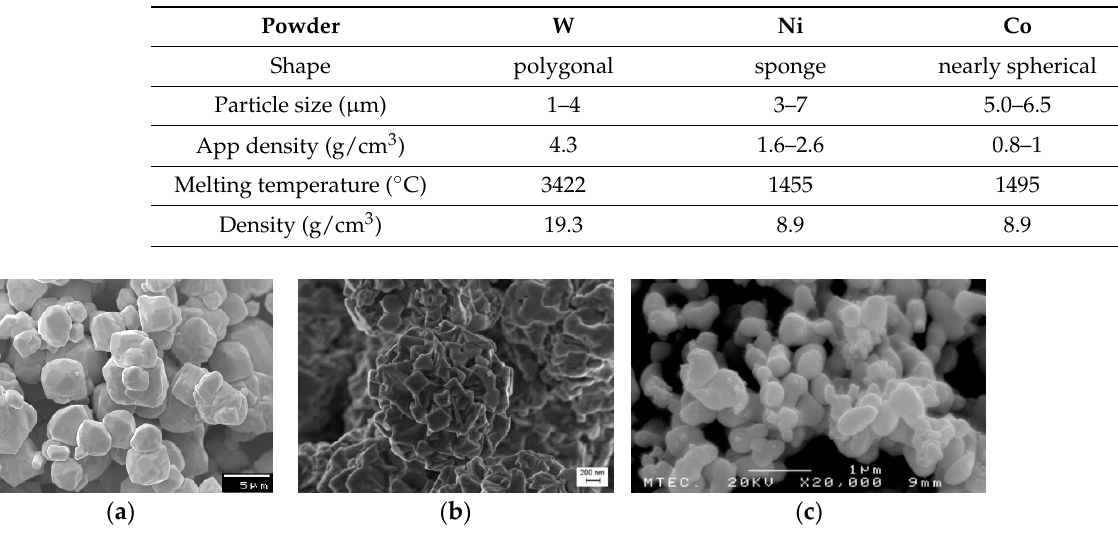
Figure 1. The morphology of the used powders. ( a ) Tungsten, ( b ) nickel, ( c ) cobalt, The first step in the production of tungsten heavy alloys was to mix the appropriate amount of powders to homogenize the blends in a drum mixer. For the selected chemical composition of WHA, the theoretical density was 17.46 g/cm 3 . The mixing time was based on previous studies [23,24] and was 20 h. The next stage was pressing in a steel die, into which about 7 kg of the powder mixture was poured each time. Pressing was carried out on a Voeller angle press under a pressure of 200 MPa. Rod-shaped moldings with a di- ameter of approximately 42 mm and a length of 510 mm were obtained. After the mold- ings were placed on the Al 2 O 3 ballast on a molybdenum tray, they were placed in a Vacuum Industries chamber furnace. Sintering was carried out in a hydrogen atmos- phere according to the assumed cycle (Figure 2). The sintering with the liquid phase took place for about 20 min at the temperature of 1520 °C with the liquid phase [25]. Figure 2. Sintering temperature diagram. After sintering, the rods were heat-treated. The aim was to make the alloy ductile so that it could be cold-worked. The heat treatment was carried out in a vacuum furnace under a reduced pressure of 5 Pa in the temperature range of 950–1150 °C. After anneal- ing, the total time of which was 9 h, and the rods were cooled rapidly [26]. The annealing temperature and time were selected based on previous tests [27–30]. In the next stage of the manufacturing process, the WHA rods were cold-worked. Before the swaging process, the rods were machined. The aim was to ensure uniform cold